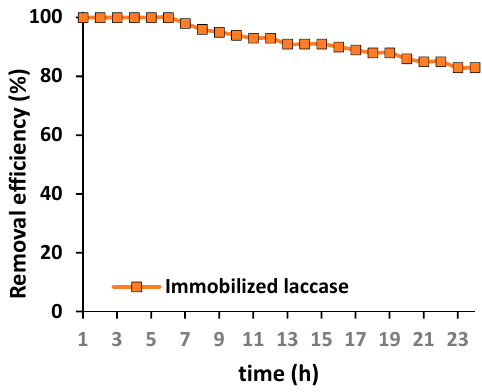
Figure 10. Efficiency of tetracycline removal over 24 h in a packed bed bioreactor containing chitinous scaffolds with immobilized laccase. The error value in each of the experiments (based on the mean and standard deviation from three experiments) does not exceed 3.5%.